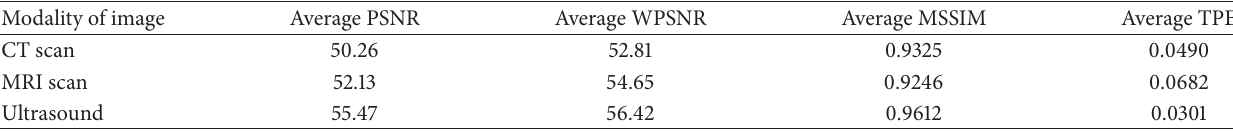
Table 4: Average performance of the proposed